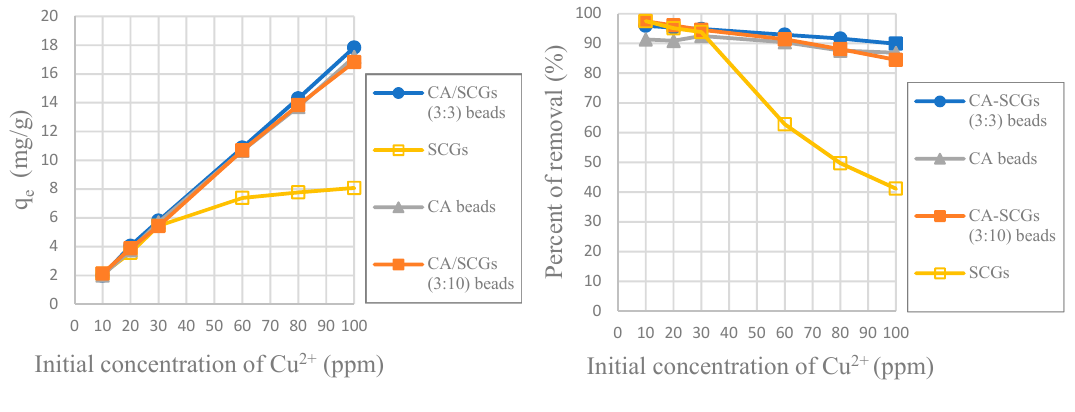
Figure 8. Plots of the amounts absorbed of Cu 2+ at equilibrium (24 h) at each initial concentration of Cu 2+ ; ( A ): Experimental amounts of Cu 2+ adsorbed at equilibrium (q e ); ( B ): Percentages of removal at equilibrium The maximum adsorption capacity value of the Sips model was 42.050 mg/g ± 0.802 mg/g for the